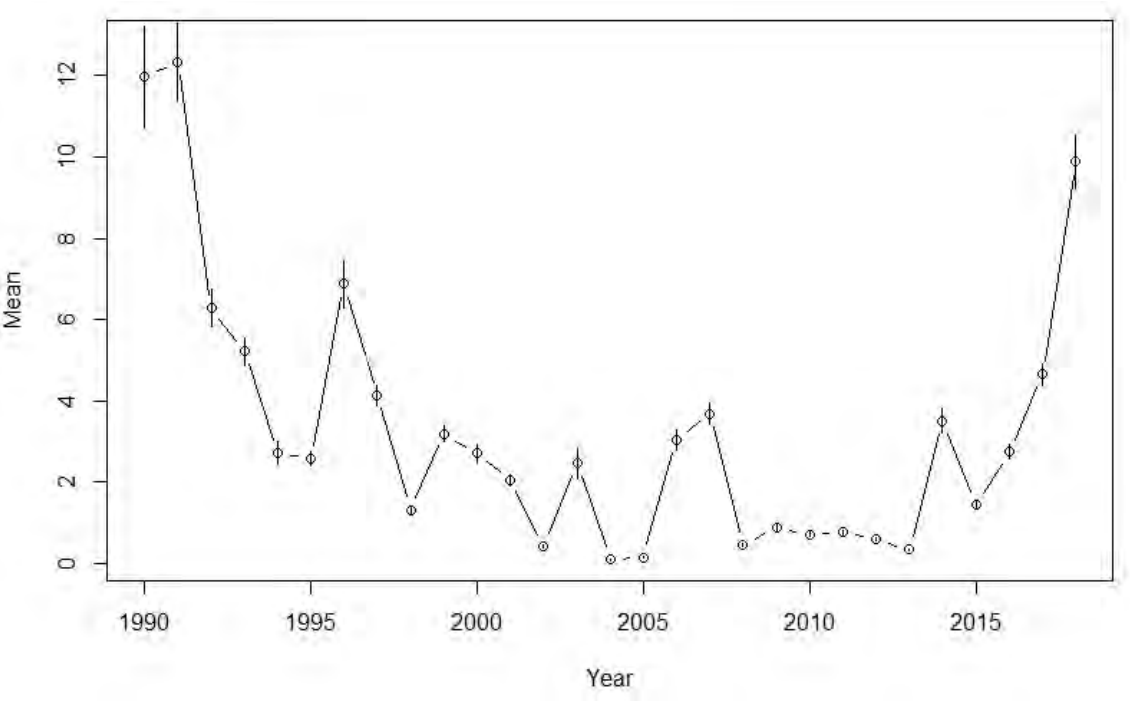
Figure 53. Delaware Fish and Wildlife Adult Trawl Survey abundance index for all adult horseshoe crabs combined in spring (March through August).